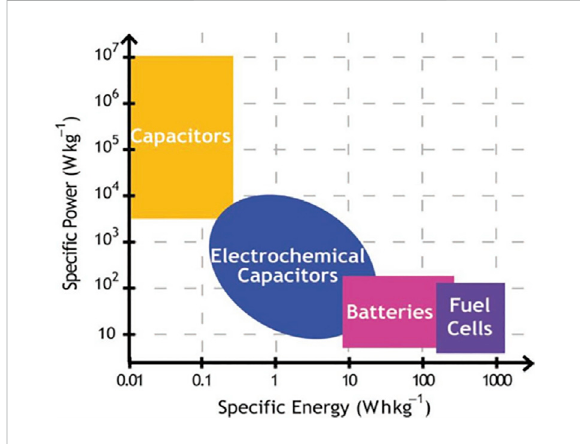
FIGURE 1 Speci fi c power/energy density of various types of energy storage systems (Wu et al.,